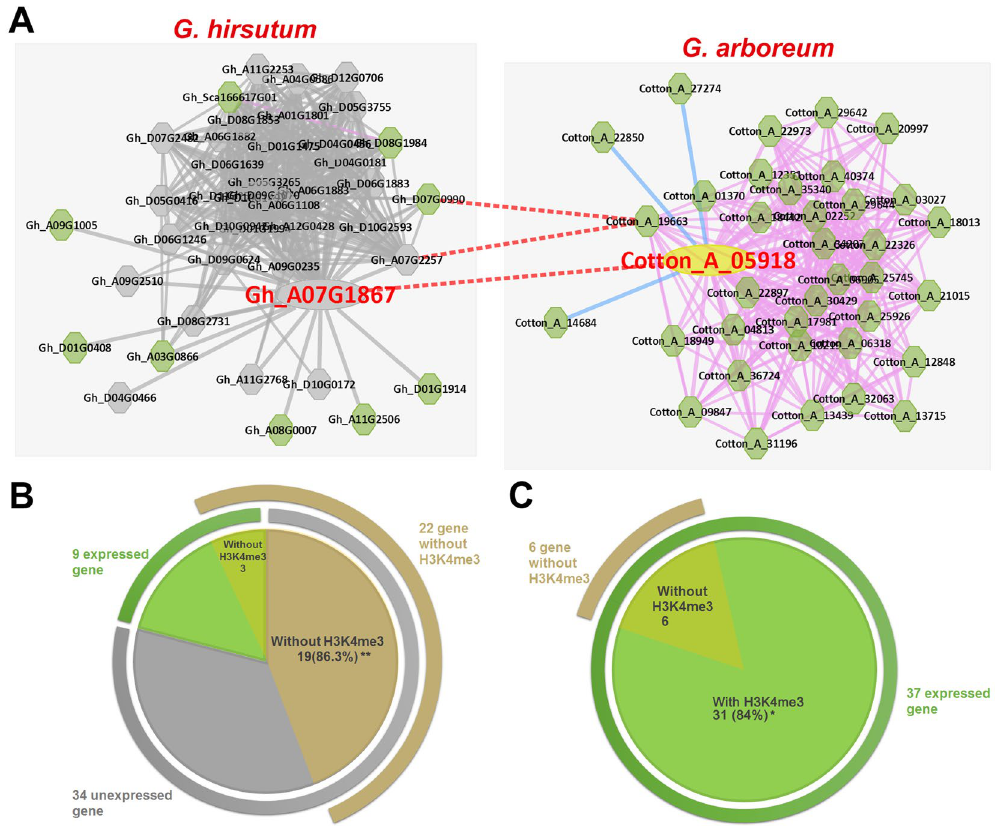
Figure 9. Modularized comparison of differential histone modification during evolution. ( A ) The co- expression networks of the orthologous gene pair of Gh_A07G1867 and Cotton_A_05918 are compared. Grey and green nodes are unexpressed and expressed genes in root tissues, respectively. A pink or blue line links positive co-expressed or negative co-expressed gene pairs, respectively. A red dotted line links orthologous gene pairs. ( B ) There are 43 co-expressed genes in the root-preferential co-expression network of Gh_A07G1867, including 9 expressed genes (green loop covers) and 34 unexpressed genes (grey loop covers). Among them, 22 co-expressed genes lack the H3K4me3 histone modification. In G. hirsutum , 50,113 genes had the H3K4me3 modification and 20,365 genes lacked it. In the sub-network, 34 genes were unexpressed in root, and among them, 15 genes had the H3K4me3 and 19 genes did not. Fisher’s Exact Test was performed, and p-values of 0.001 are marked by ** . ( C ) There are 37 co-expressed genes in the root-preferential co-expression network of Cotton_A_05918, and all of them are expressed in root. Among these, 6 co-expressed genes did not have H3K4me3 histone modification. In G. arboreum , 28,923 genes had the H3K4me3 modification and 12,408 genes did not. In the sub-network, 37 genes were expressed in root and among them, 31 genes had the H3K4me3 and 6 genes did not. Fisher’s Exact Test was performed, and the p-value was 0.073 and marked by *